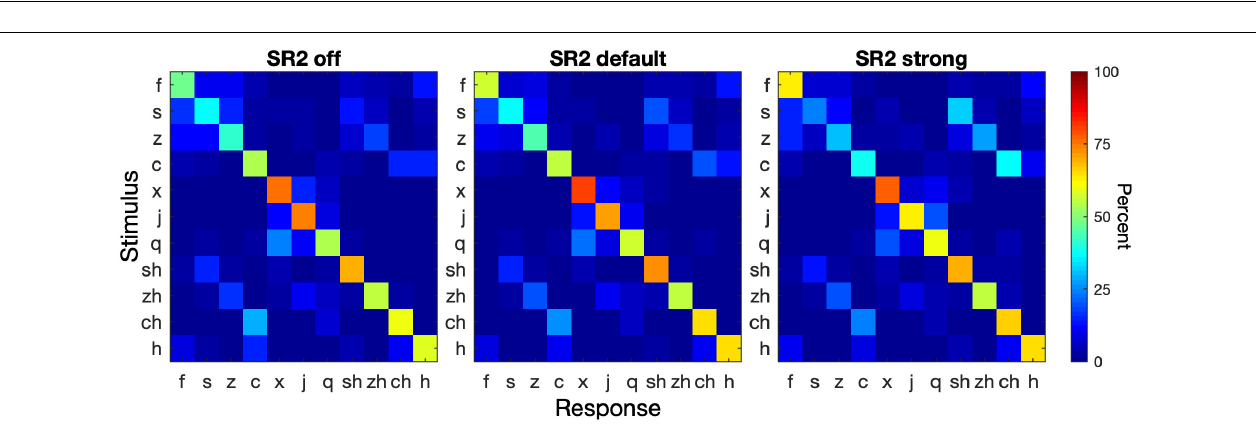
FIGURE 6 | Group mean performance of speech-recognition performance. The three panels are for consonant and vowel recognition in quiet, and sentence recognition in noise (+5 dB SNR), respectively. The three different lines represent the group mean results for the three SR2 settings.